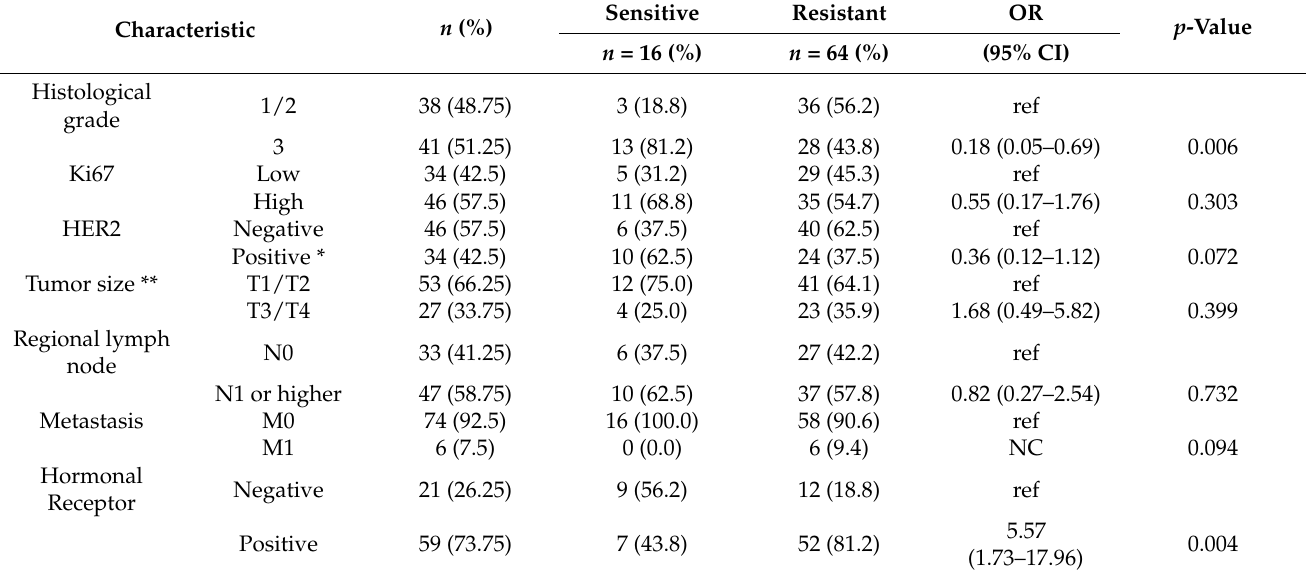
Table 2. Main breast cancer features as related to response to neoadjuvant